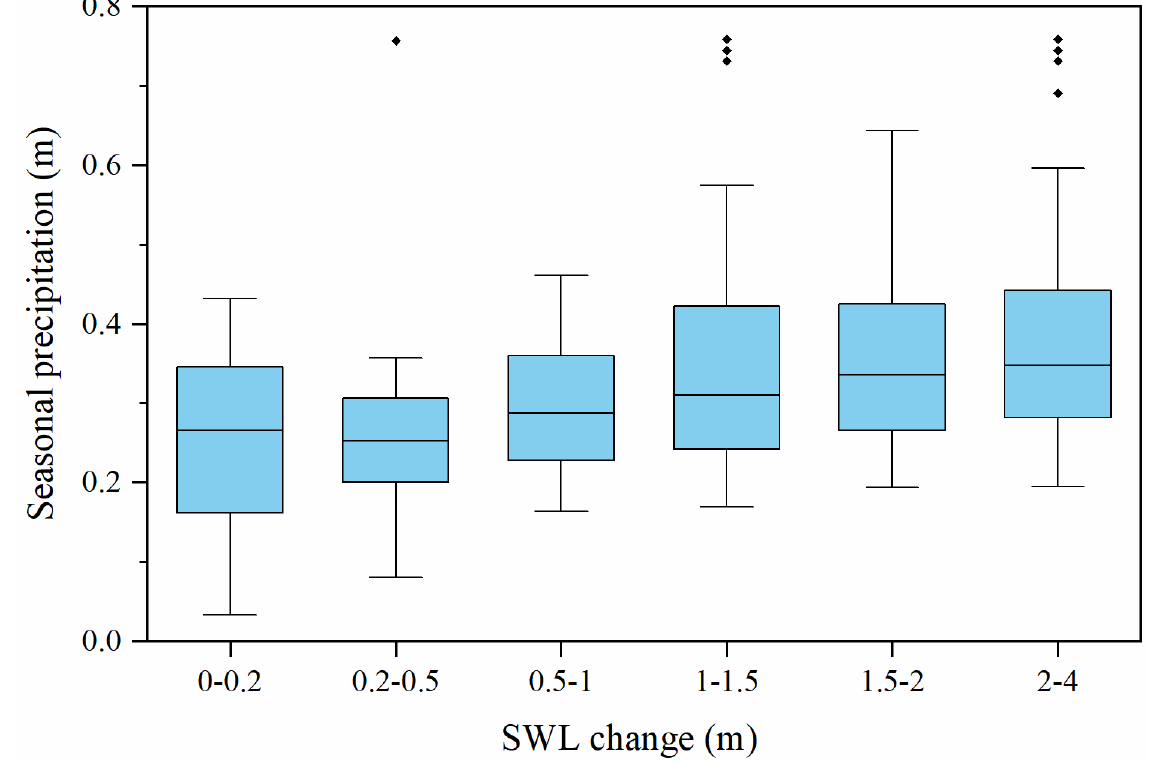
Figure 9. Seasonal amplitudes of accumulated precipitation of the grid-based clusters in different SWL change areas. Black rhombuses are outliers in each SWL change group.